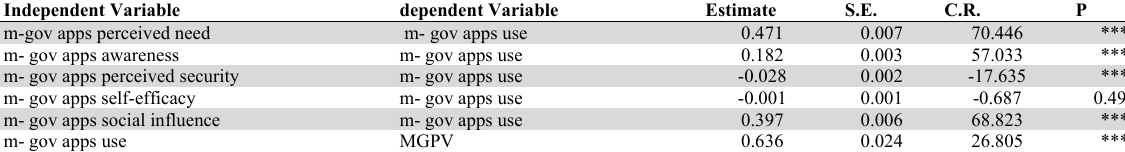
The estimation of m-government public value hypotheses Independent Variable dependent